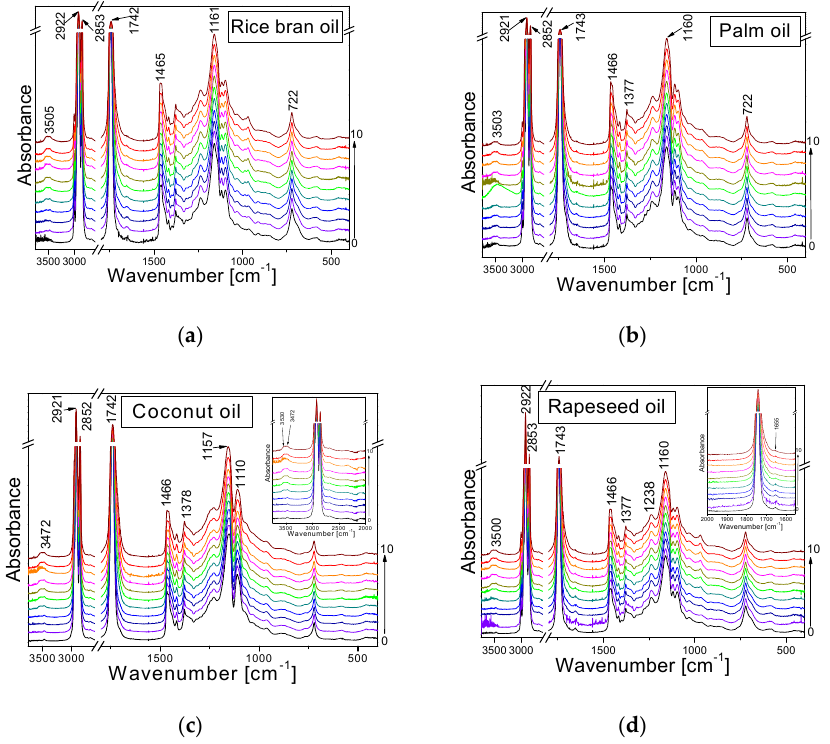
Figure 2. FT-IR spectra of the studied oils: rice bran ( a ), palm ( b ), coconut ( c ), and rapeseed oil ( d ), heated at 180 °C in 10 cycles per 4 h. The spectrum “0” (black color) is for the unheated sample. The spectra are ordered from bottom to top according to the increasing number of cycles.